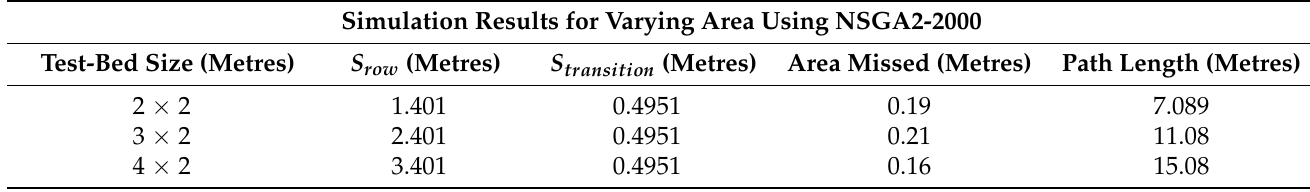
Table 2. Consolidated simulation results for varying area.